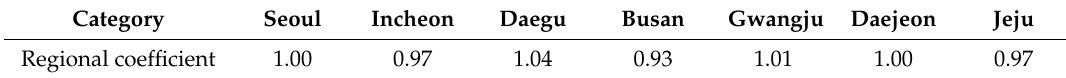
Table 3. Regional coefficients according to climate conditions in